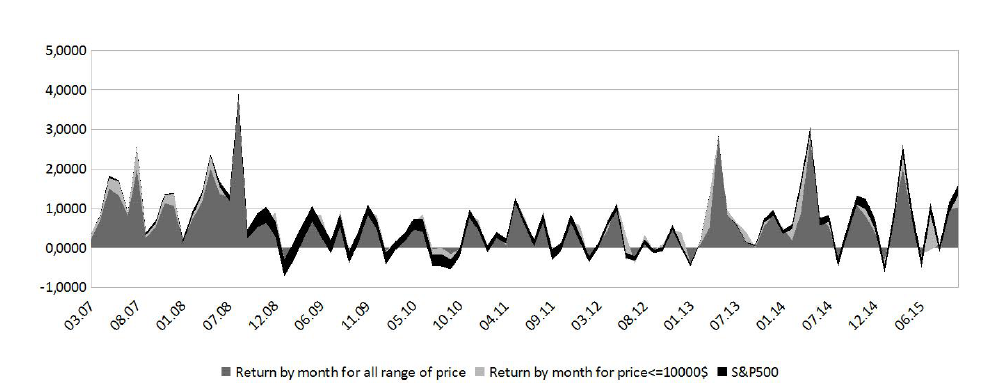
Figure 7. Cumulative dynamics of the art price index for the modern